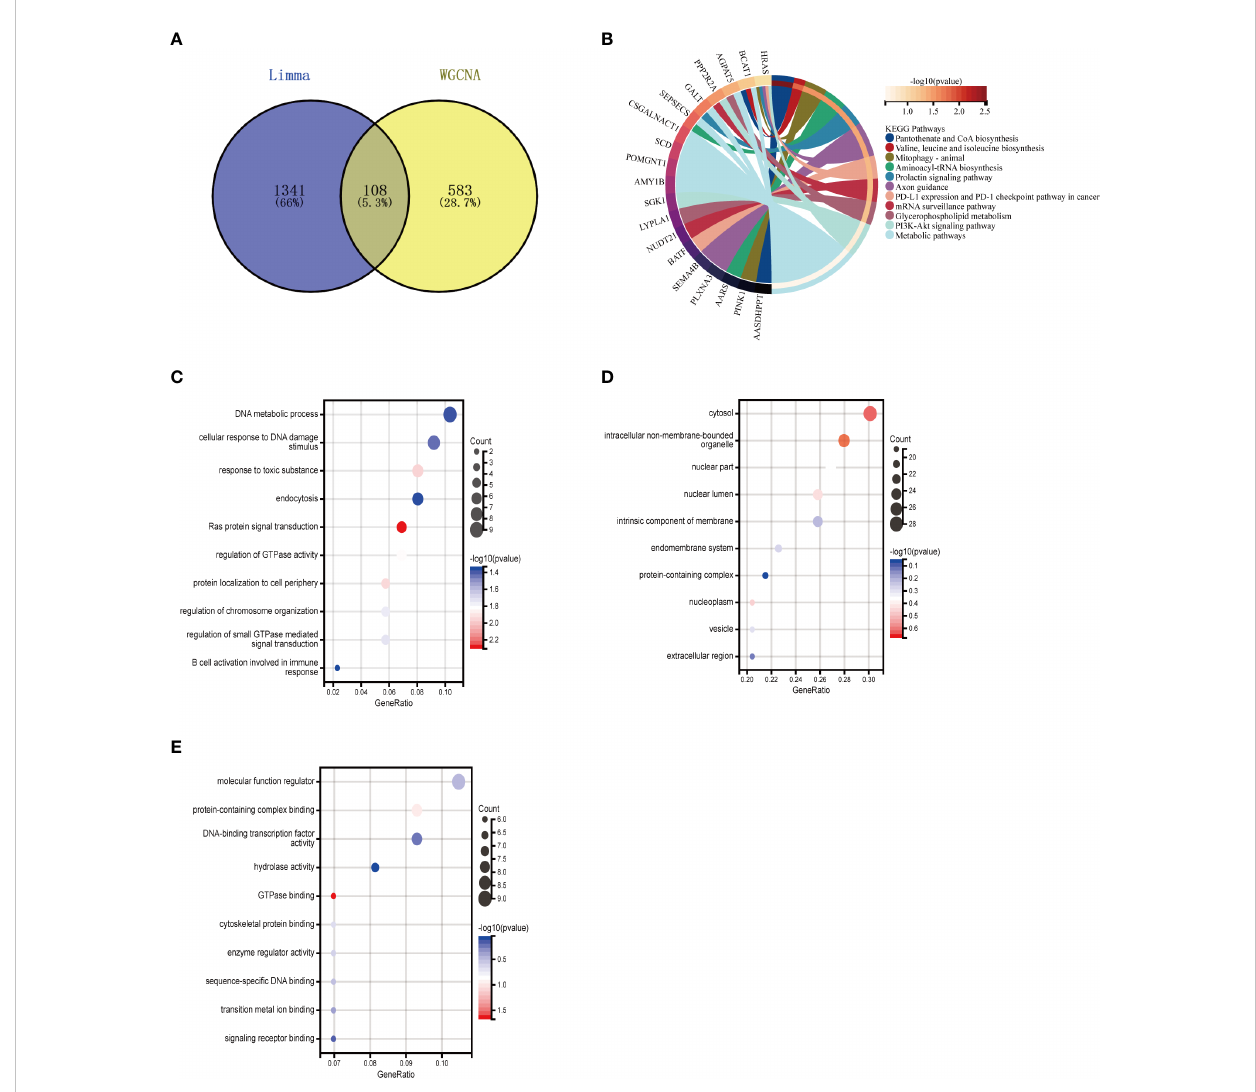
FIGURE 4 Enrichment analysis of the intersection of genes in MetS. (A) Venn diagram shows that 108 genes are identi fi ed from the intersection of DEGs via Limma and yellow module genes via WGCNA. (B) KEGG pathway analysis of the intersection of genes. Different colors represent various signi fi cant pathways and related enriched genes. (C – E) GO analysis of the Intersection of genes, including biological process, cellular component, and molecular function, respectively. The y-axis represents different GO terms, the x-axis represents gene ratio enriched in relative GO terms, the circle size refers to gene numbers, and the color represents p-value. MetS, Metabolic syndrome: KEGG, Kyoto Encyclopedia of Genes and Genomes GO, Gene Ontology: WGCNA, weighted gene co- expression network analysis: Limma, linear models for microarray datac DEGs, differentially expressed